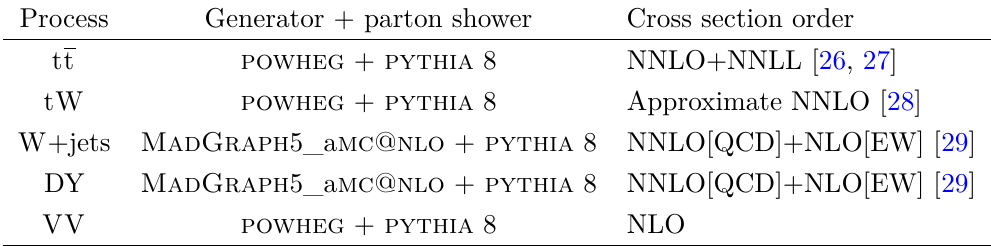
Table 1 . Summary of MC samples used to model the signal and background processes. The column “Cross section order” corresponds to the QCD or electroweak (EW) precision used to normalize the distributions provided by the generators. Where no reference is given, the precision of the MC simulation is